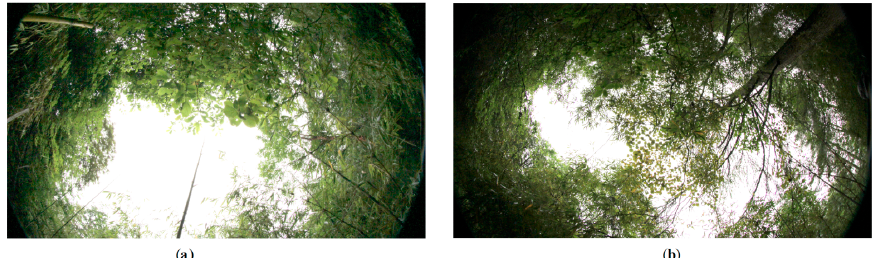
Figure 13. Tree crown photos taken using a fisheye camera at the testing locations. ( a ) The bamboo class surrounded by brush and was correctly classified; ( b ) the bamboo class covered by mixed woodland and was misclassified as brush.